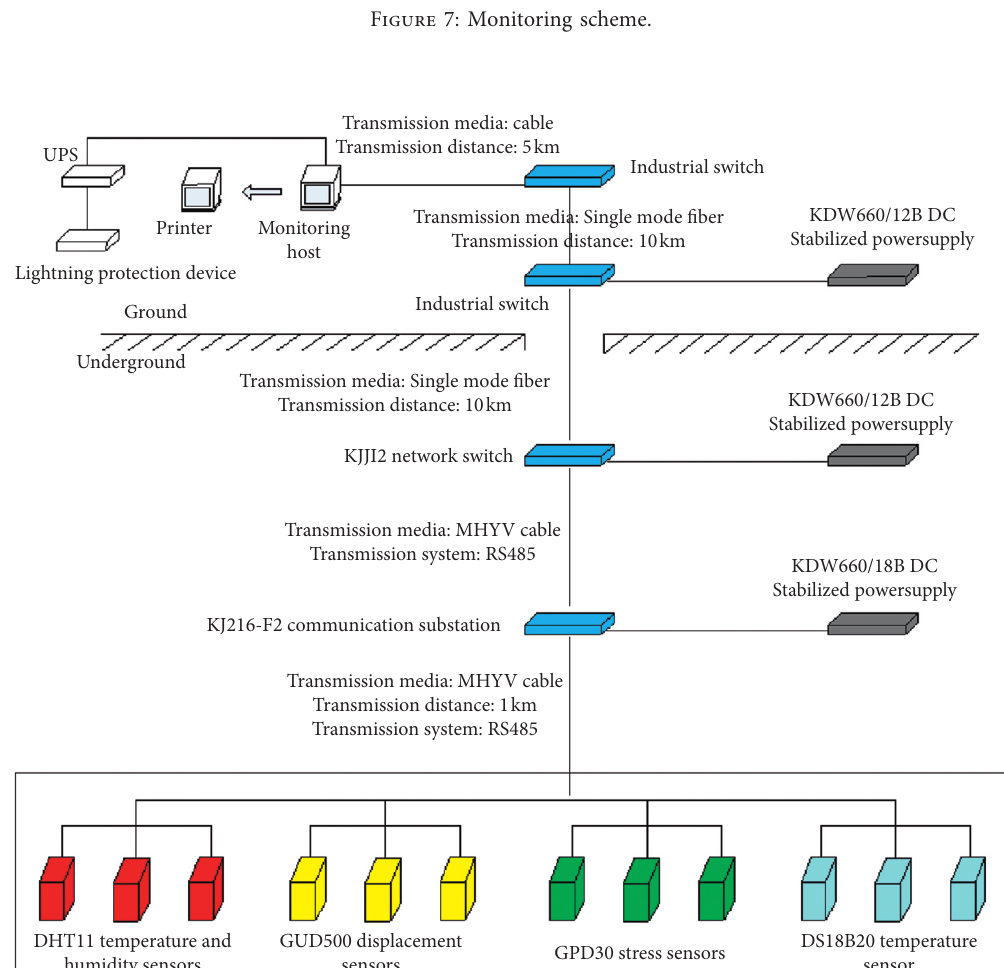
Figure 8: The online monitoring